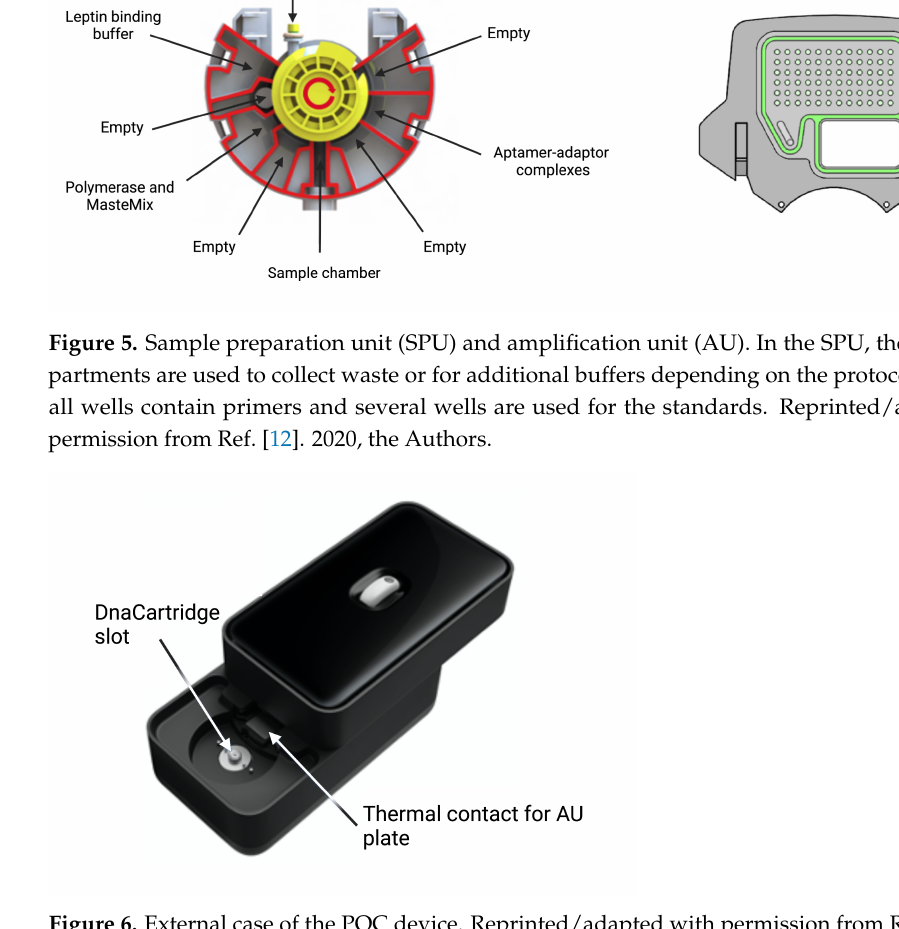
Figure 6. External case of the POC device. Reprinted/adapted with permission from Ref. [12]. 2020, the